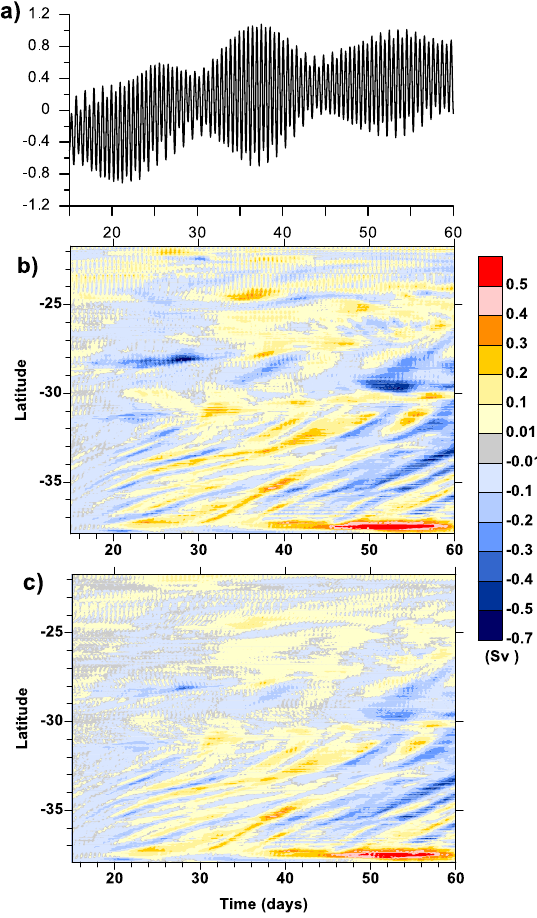
daily and spring-neap tidal cycles b Difference in flow tangent to the continental shelf break at 200 m between the tidal and non-tidal simulations. c Same as b for water colder than 18 °C. Negative values indicate either an increase in a southward flow or a decrease in a northward